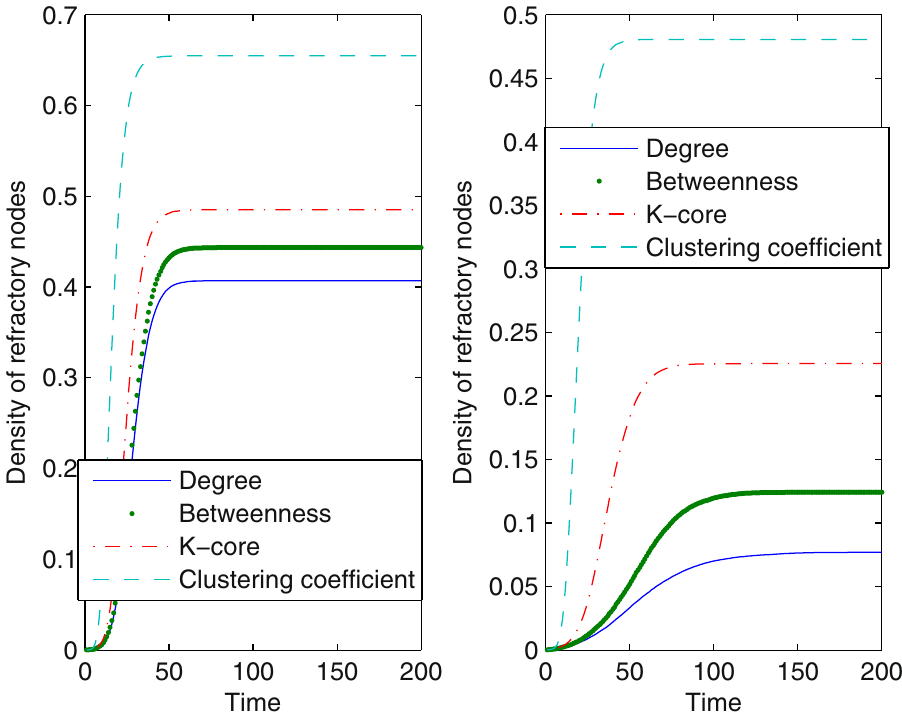
Figure 2. Density of refractory nodes as a function of time with the method of blocking different nodes. The underlying network is a scale-free network, N = 2500, λ = 0.2, and δ = 0.2. In the left plot, the proportion of nodes that are blocked is γ = 0.01. In the right plot, γ is set at 0.05. Every plot is an average of 100 different